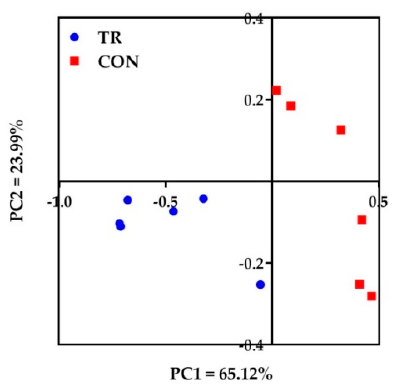
Figure 1. Unweighted UniFrac metric PCoA of microbial diversity in CON and TR groups. The percentage of variation explained by PC1 and PC2 are indicated on the axis.